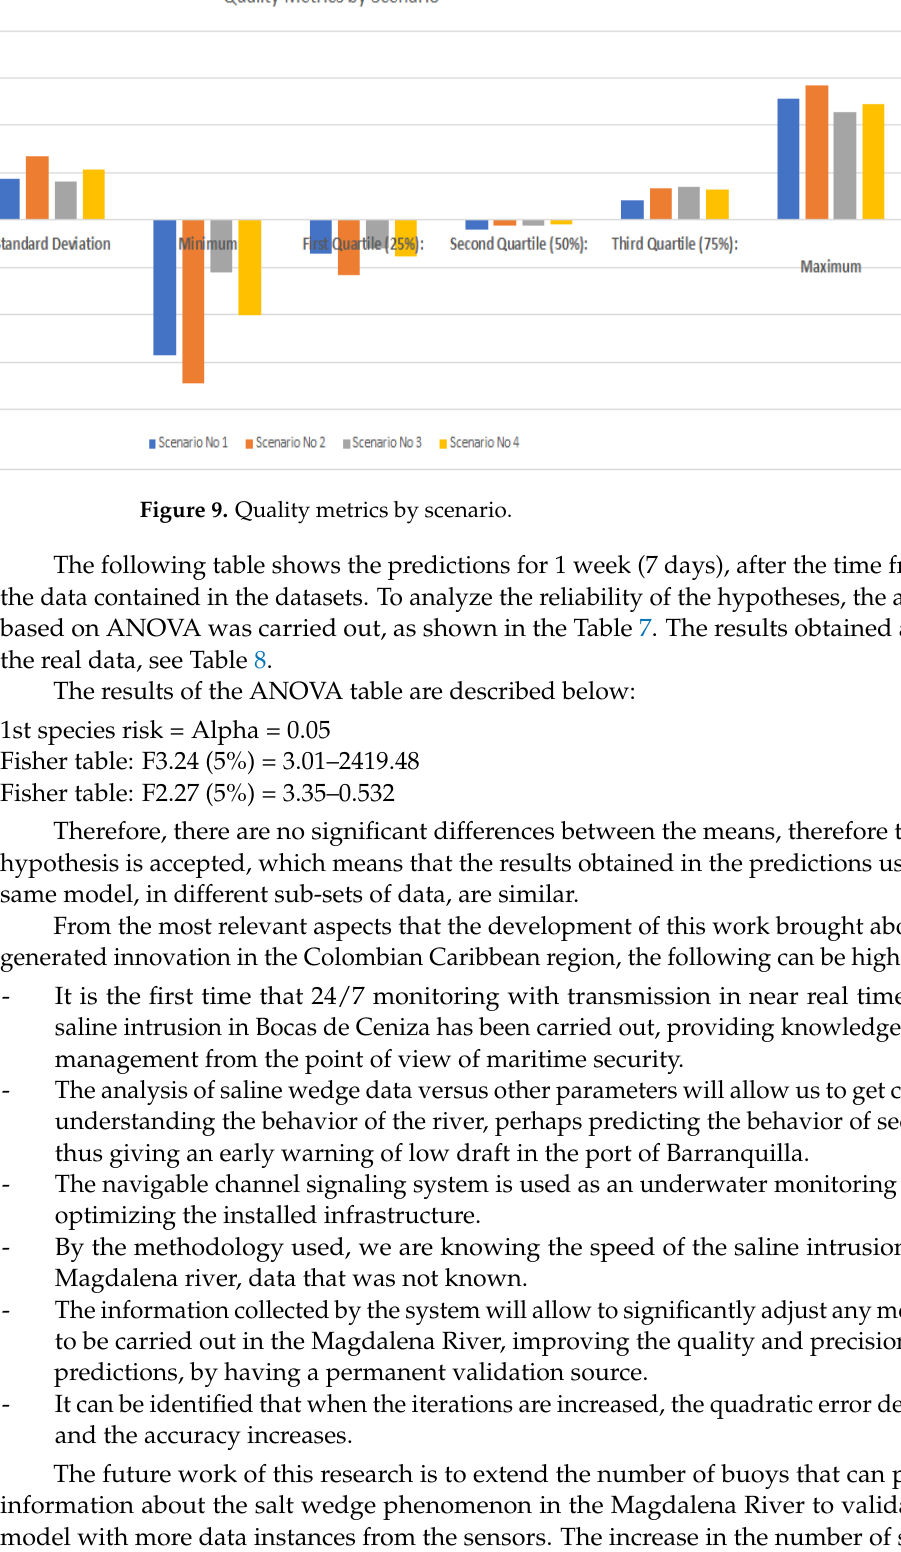
( d ) Figure 8. ( a ) Mean Square Error Scenario 1, ( b ) Mean Square Error Scenario 2, ( c ) Mean Square Error Scenario 3, ( d ) Mean Square Error Scenario 4.